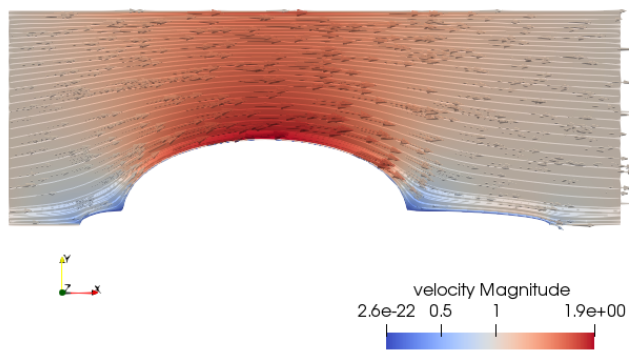
Figure 30. Case 6: the velocity representation with stream